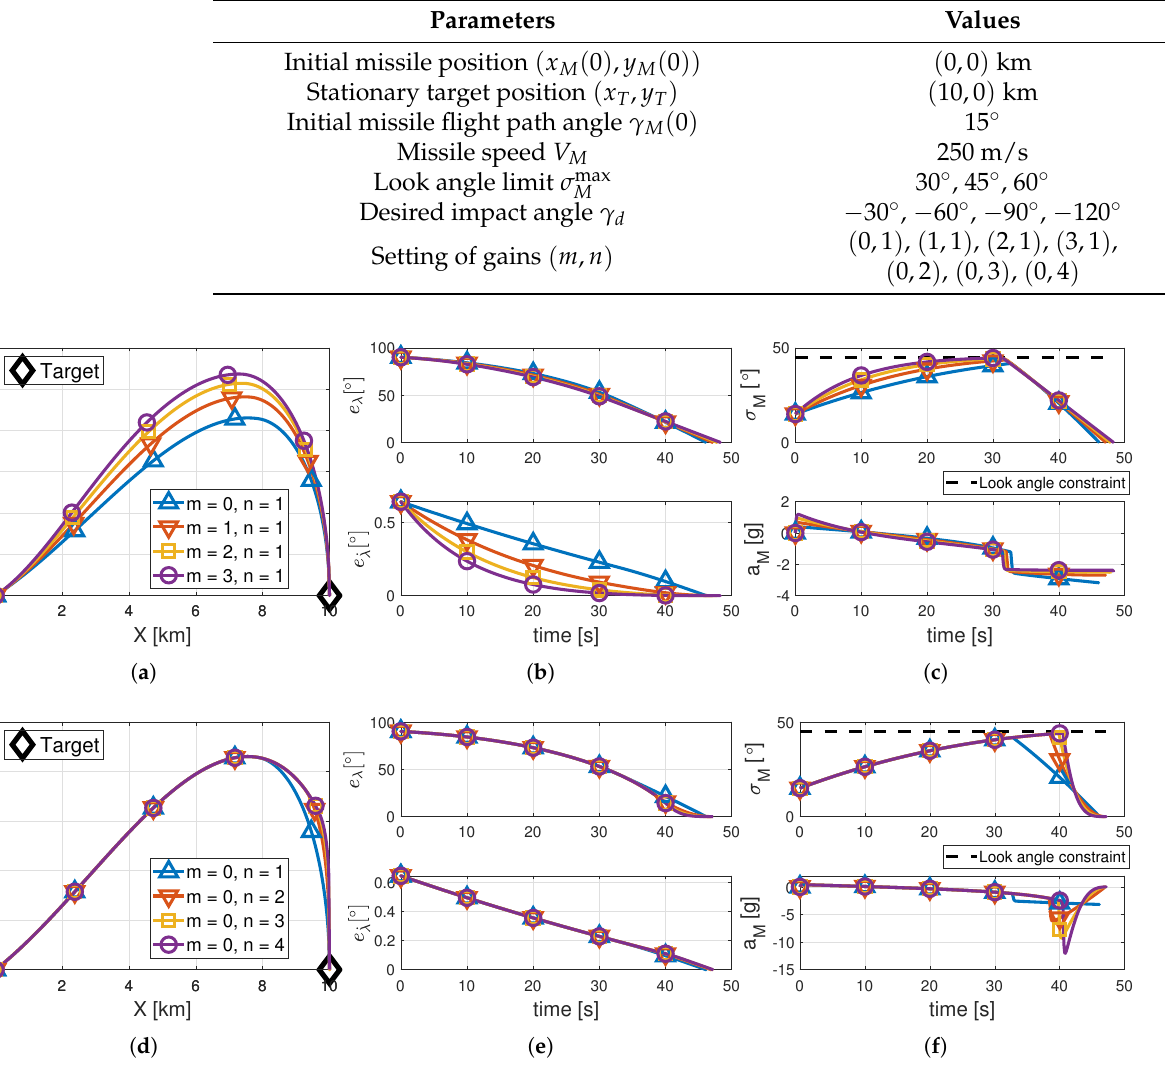
Table 1. Simulation settings.